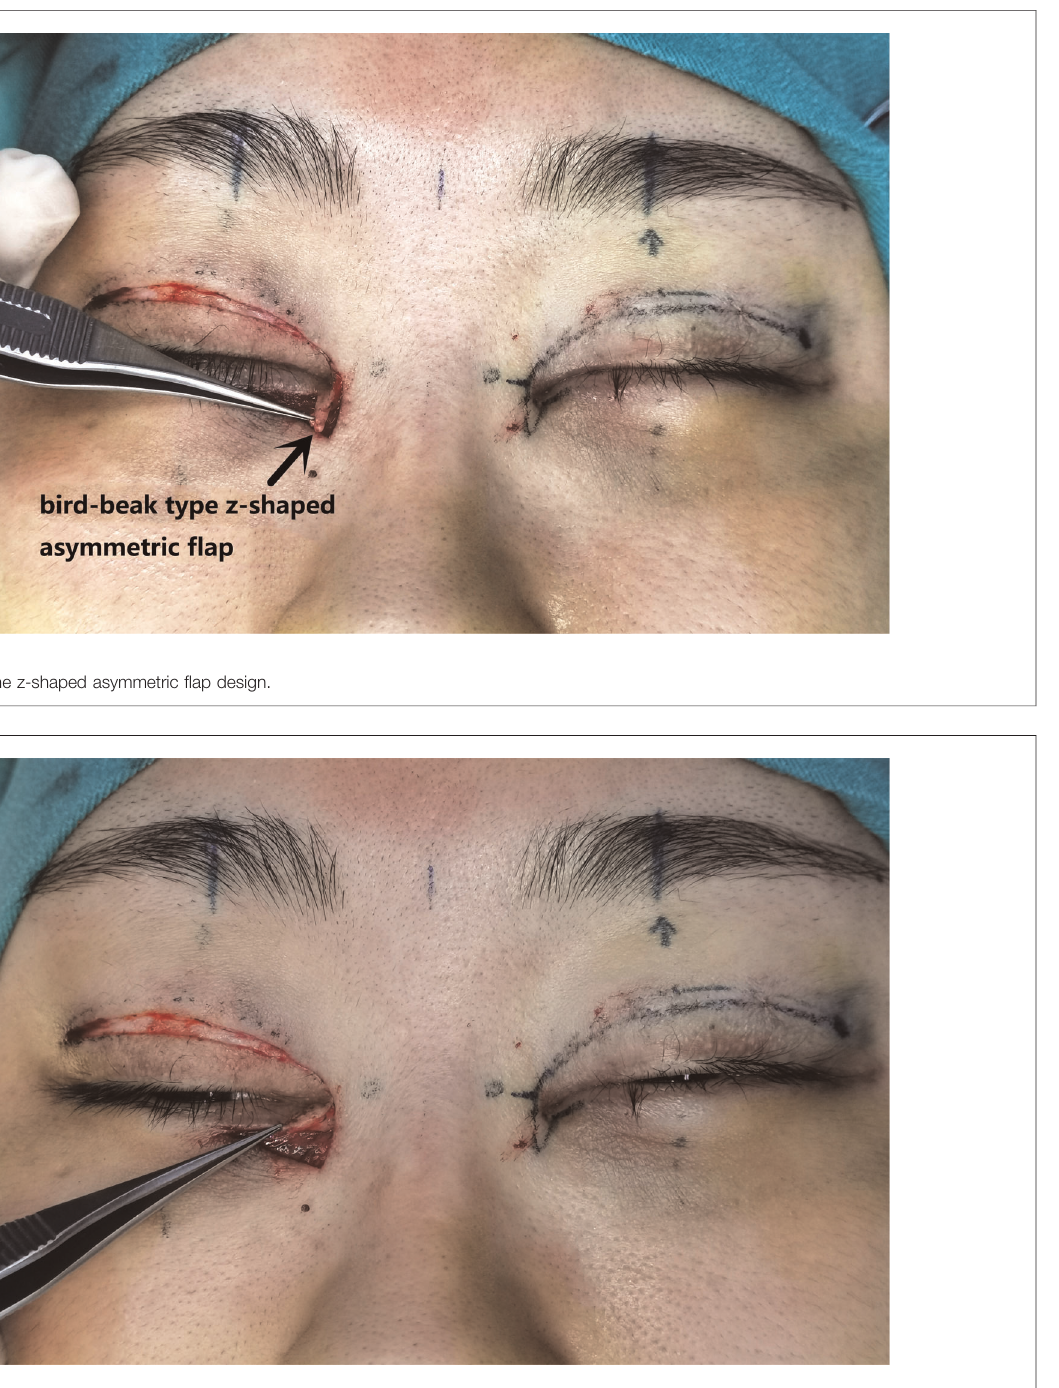
FIGURE 3 | Short-arm scar fascia fl ap turned 180 degrees upward as the lining of the inner